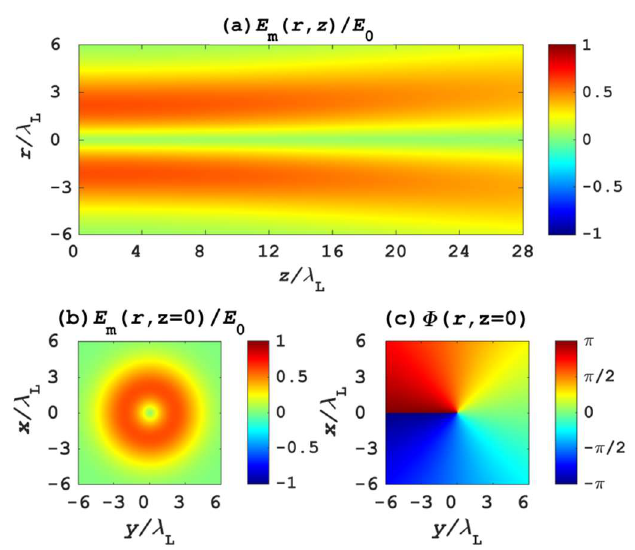
Figure 1. The field magnitude and phase distributions of the doughnut-shaped Laguerre-Gaussian vortex laser beam of LG 1 0 mode in free space: ( a ) The longitudinal view of the normalized field magnitude distribution E m ( r , z ) / E 0 ; ( b ) the cross-sectional view of the normalized field magnitude distribution E m ( r , z = 0 ) / E 0 on the plane of beam waist; ( c ) the cross-sectional view of principal argument distribution Φ ( r , z = 0 ) of the complex field of laser beam on the plane of beam waist.